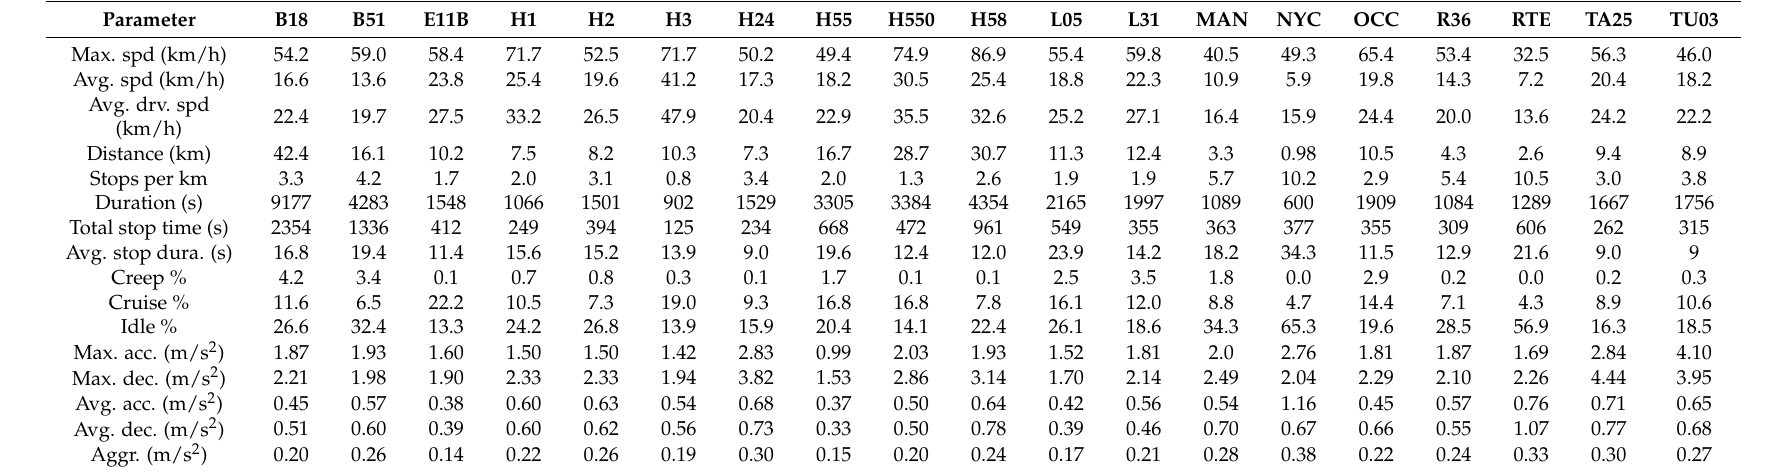
Table 4. Bus driving cycle characteristic